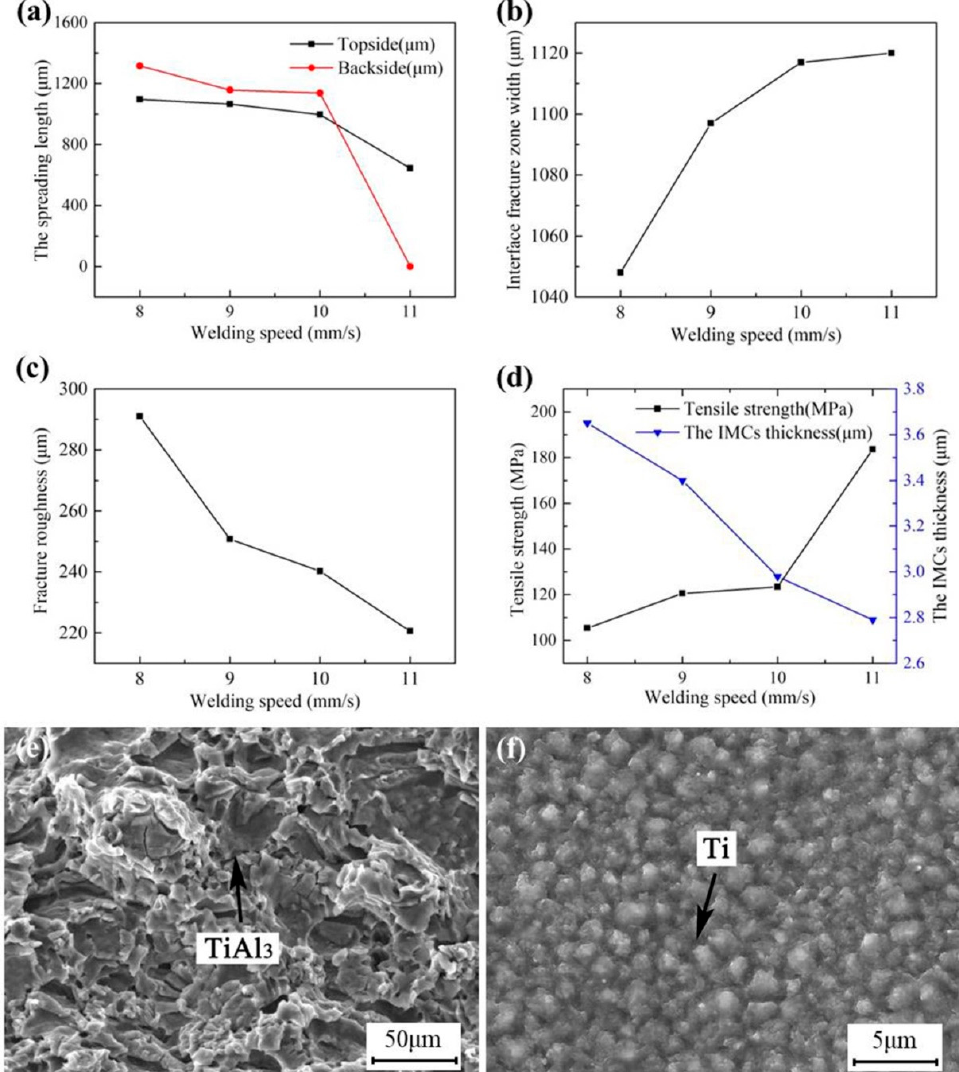
Figure 8. Influence of welding speed on the joint properties: ( a ) the spreading length; ( b ) interface fracture zone width; ( c ) fracture roughness; ( d ) tensile strength and the IMC thickness, and the details of the fracture of Joint #9: ( e , f ) details of Areas Z4 and Z5 in Figure 4b, respectively.